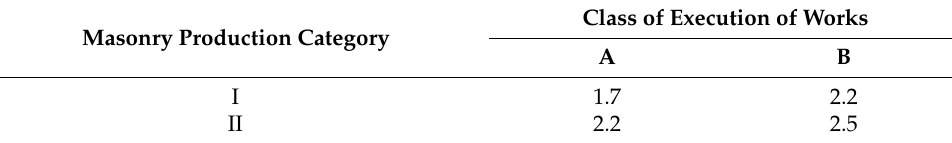
Table 2. Values of partial safety factors for masonry according to PN-B-03002:1999 [20]. Masonry Production